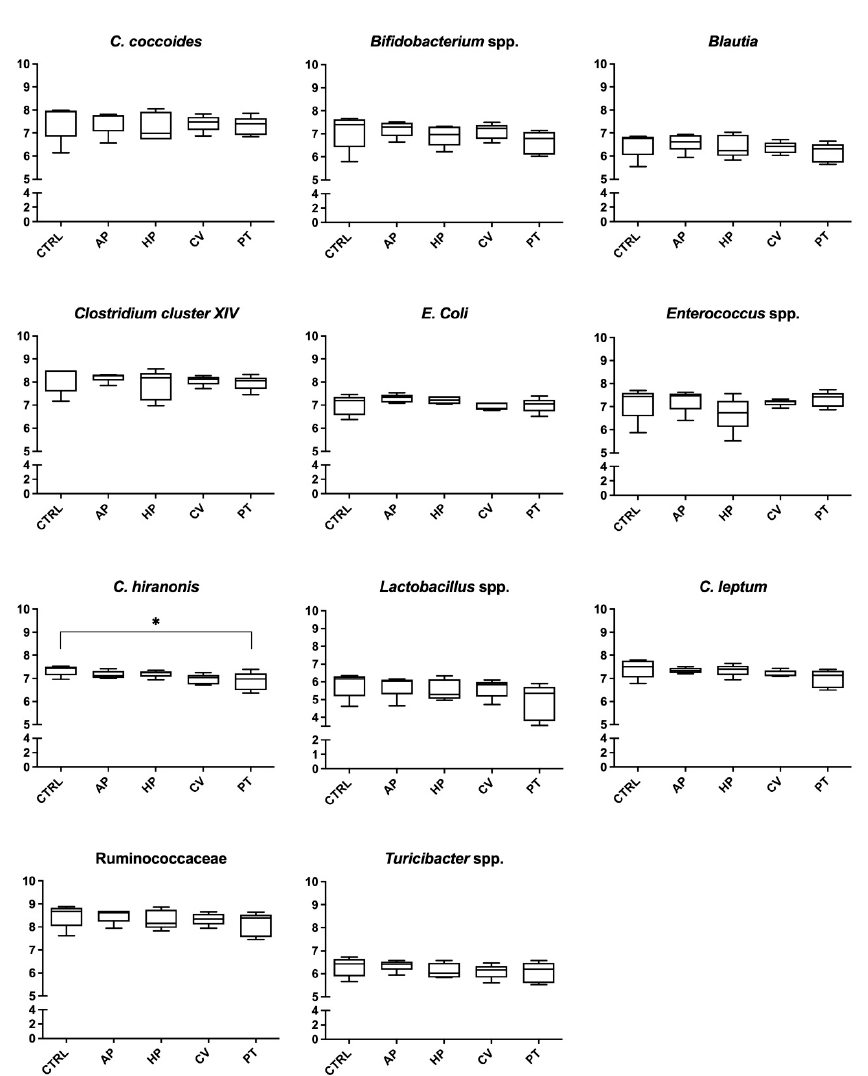
Figure 1. Microbial analysis (log 10 copies DNA/75 ng DNA) after 6 h of an in vitro incubation of canine fecal inoculum with a control diet supplemented with microalgae. Values are the means of five bottles per treatment. CTRL, control; AP, Arthrospira platensis ; HP, Haematococcus pluvialis ; CV, Chlorella vulgaris ; PT, Phaeodactylum tricornutum . * p < 0.05.